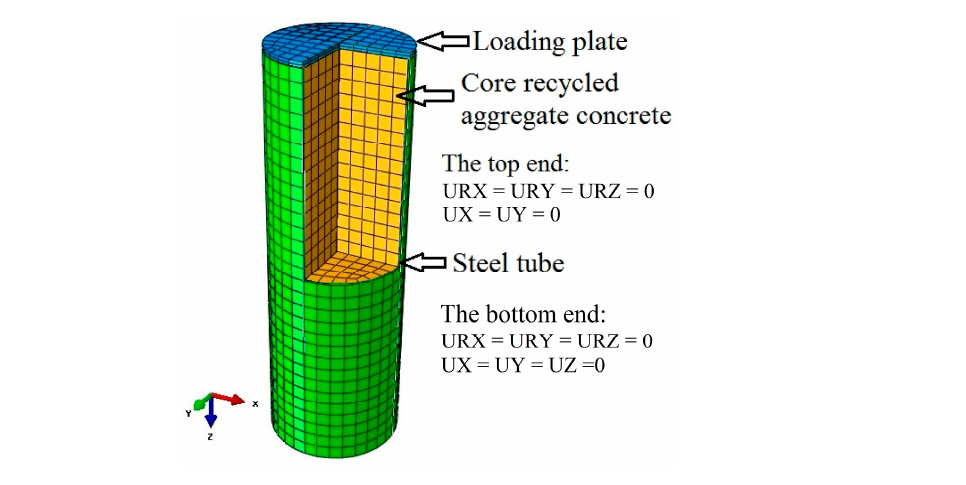
Figure 2. Meshing and boundary conditions of the RACFCST stub column FE model.